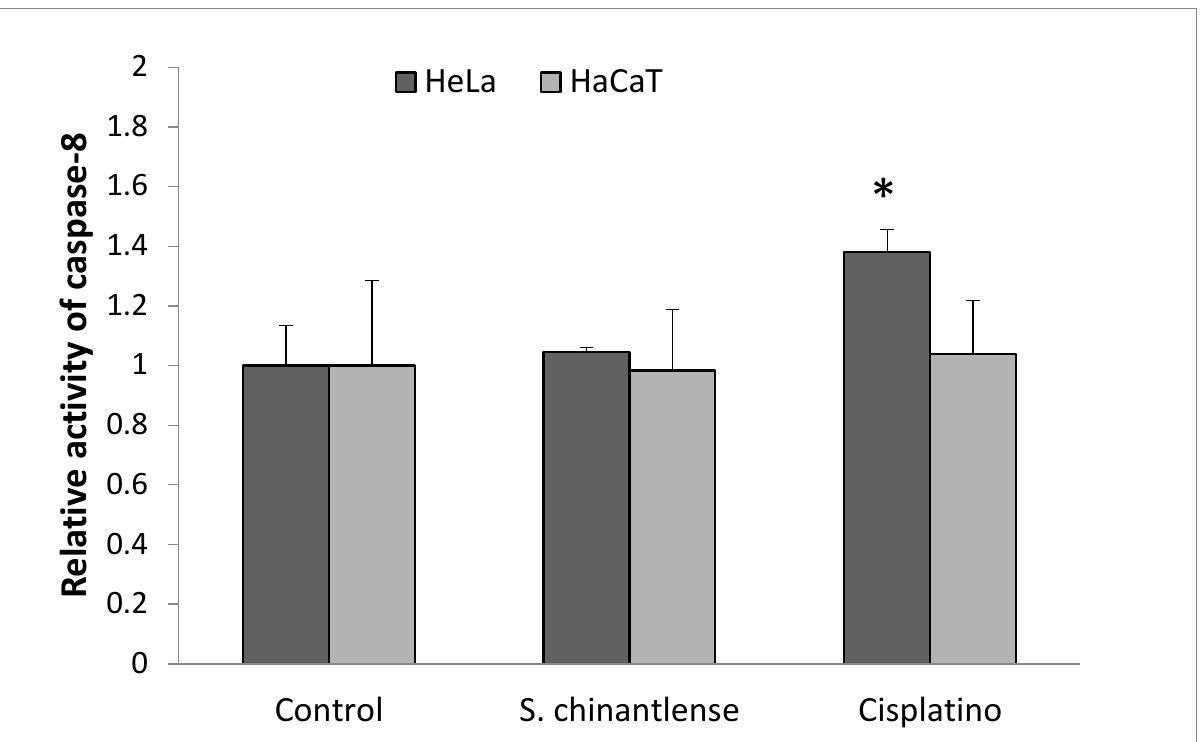
Figure 5. Activation of caspase-8 in HeLa cancer cells after incubation with S. chinantlense extract or cisplatin at the IC 50 value for 24 h. The values are presented as the mean ± S.D., where ∗ indicates a significant difference relative to the control ( p < 0.05).